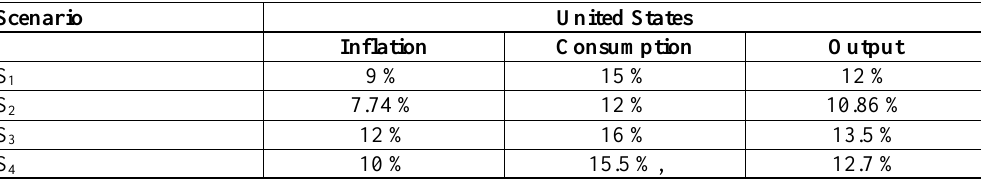
Table 5. Initial Macroeconomic Loss from